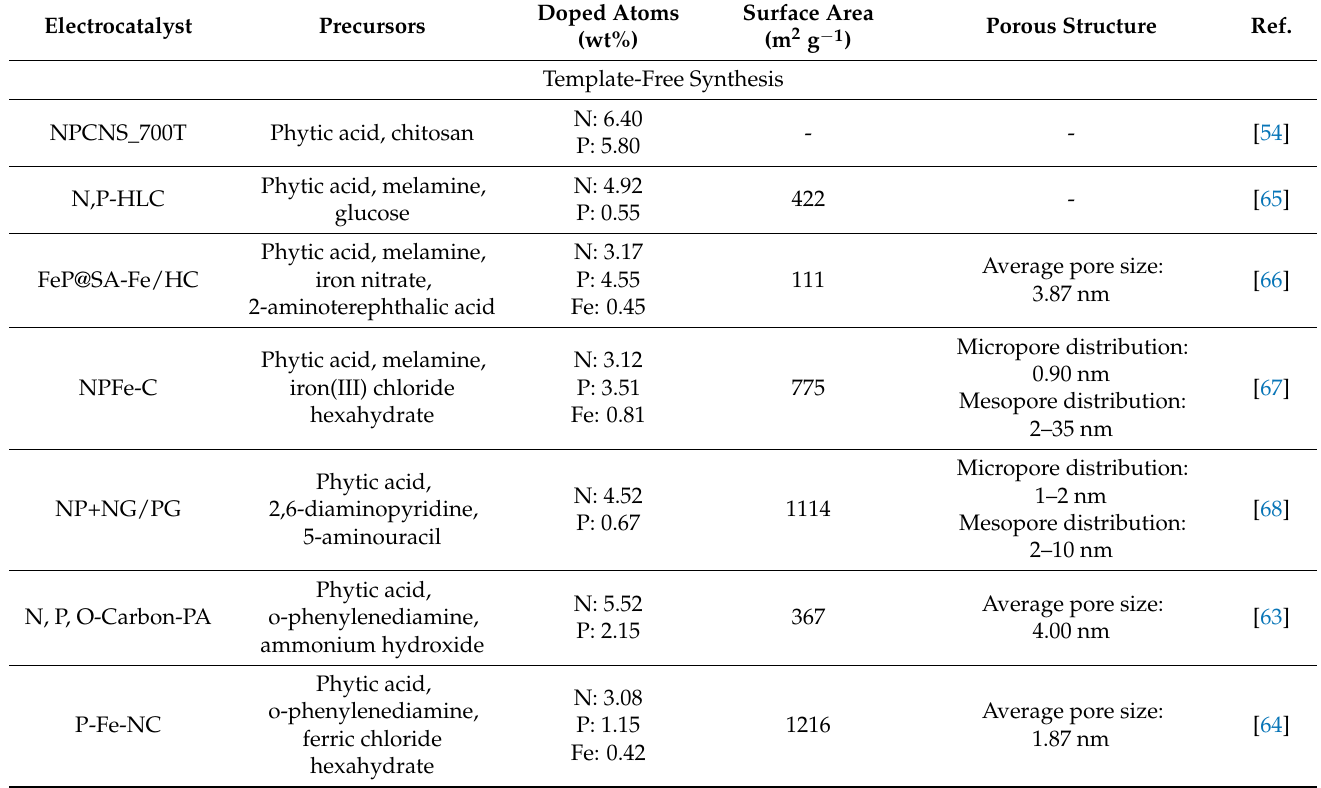
Table 1. Physicochemical properties of PA-derived carbon materials obtained via template-free